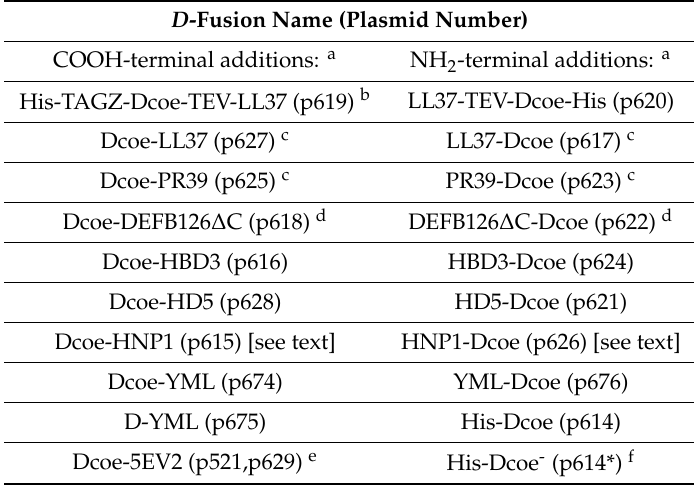
Table 1. Overview of D -fusion gene constructs cloned into the pcIpR-GOI-timm expression vector. D -Fusion Name (Plasmid Number) COOH-terminal additions: a NH 2 -terminal additions: